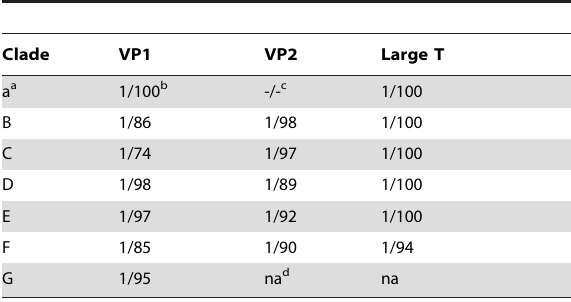
Table 3. Branch support values for selected clades in VP1, VP2 and large T phylogenetic analyses.